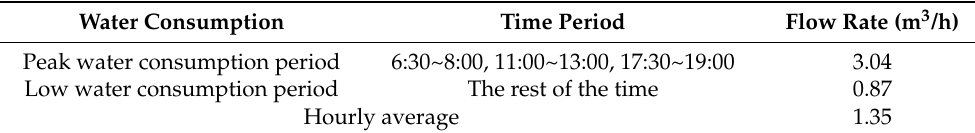
Table 2. Peak time period and flow rate of water use in rural areas.